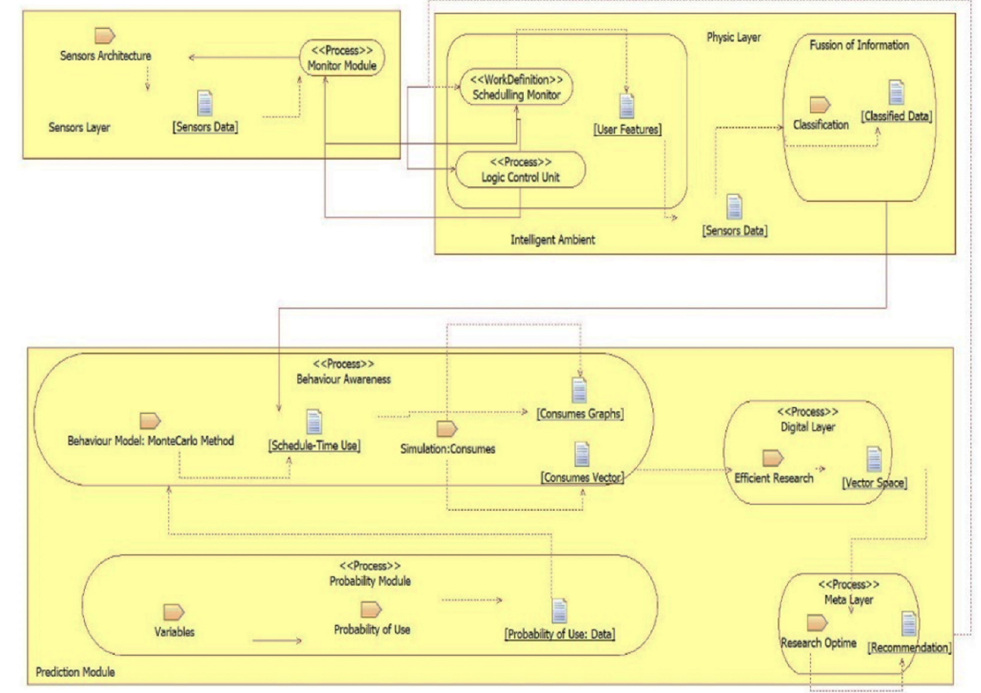
Figure 1. Home energy management system with IoT Demand System Architecture.